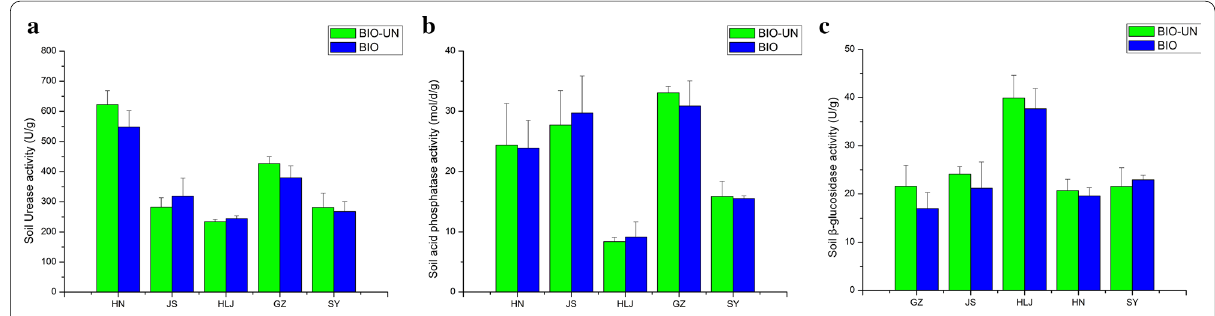
Fig. 7 Soil enzyme activity in the BIO-treated and untreated soil at five site soils. a soil urease, b soil acid phosphatase, c soil β-glucosidase. Vertical bars indicate standard deviation of the mean (n 3). For each parameter, different letters indicate significant differences between means at p < 0.05. = The HN, JS, HLJ, GZ and SY represent BIO treated and untreated soil samples at the five rice paddy sites in